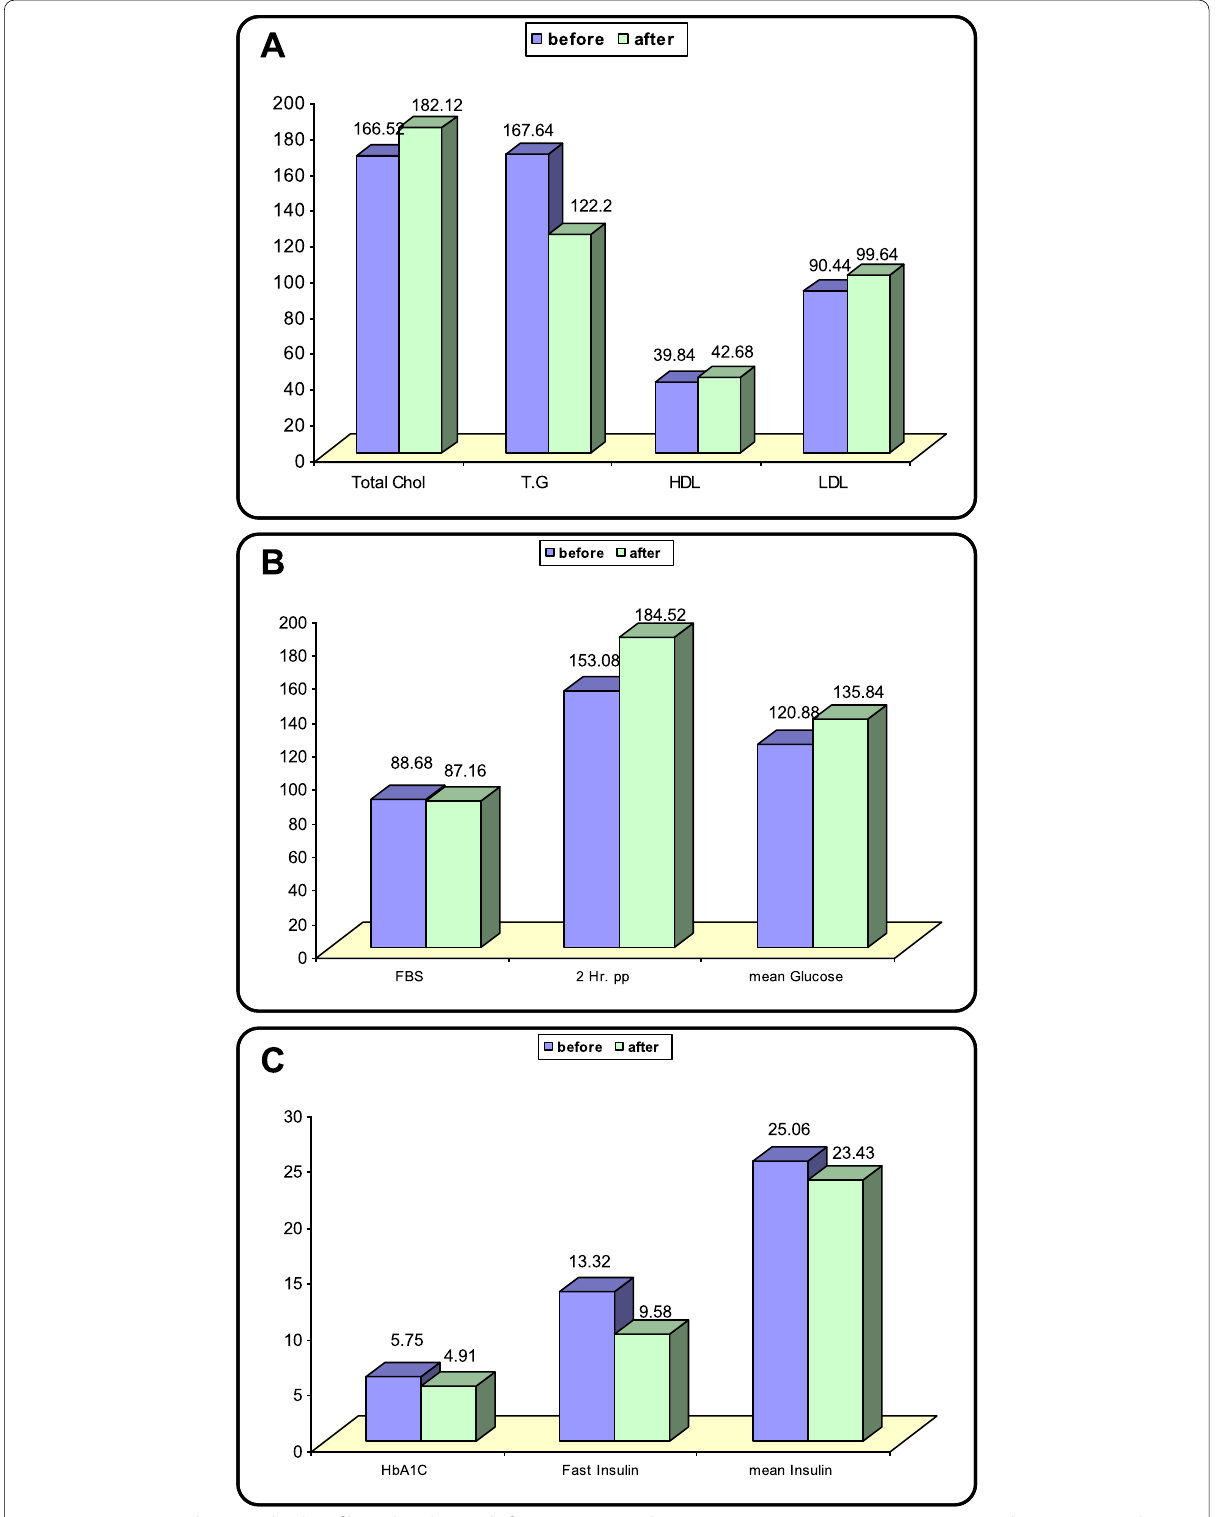
Fig. 4 A Comparison between lipid profiles at baseline and after SVR at 12 weeks among patients in group C. B Comparison between FBS, 2‑h postprandial blood glucose, and mean glucose levels at baseline and after SVR at 12 weeks among patients in group C. C Comparison between HbA1C, fasting insulin, and mean insulin levels at baseline and after SVR at 12 weeks among patients in group